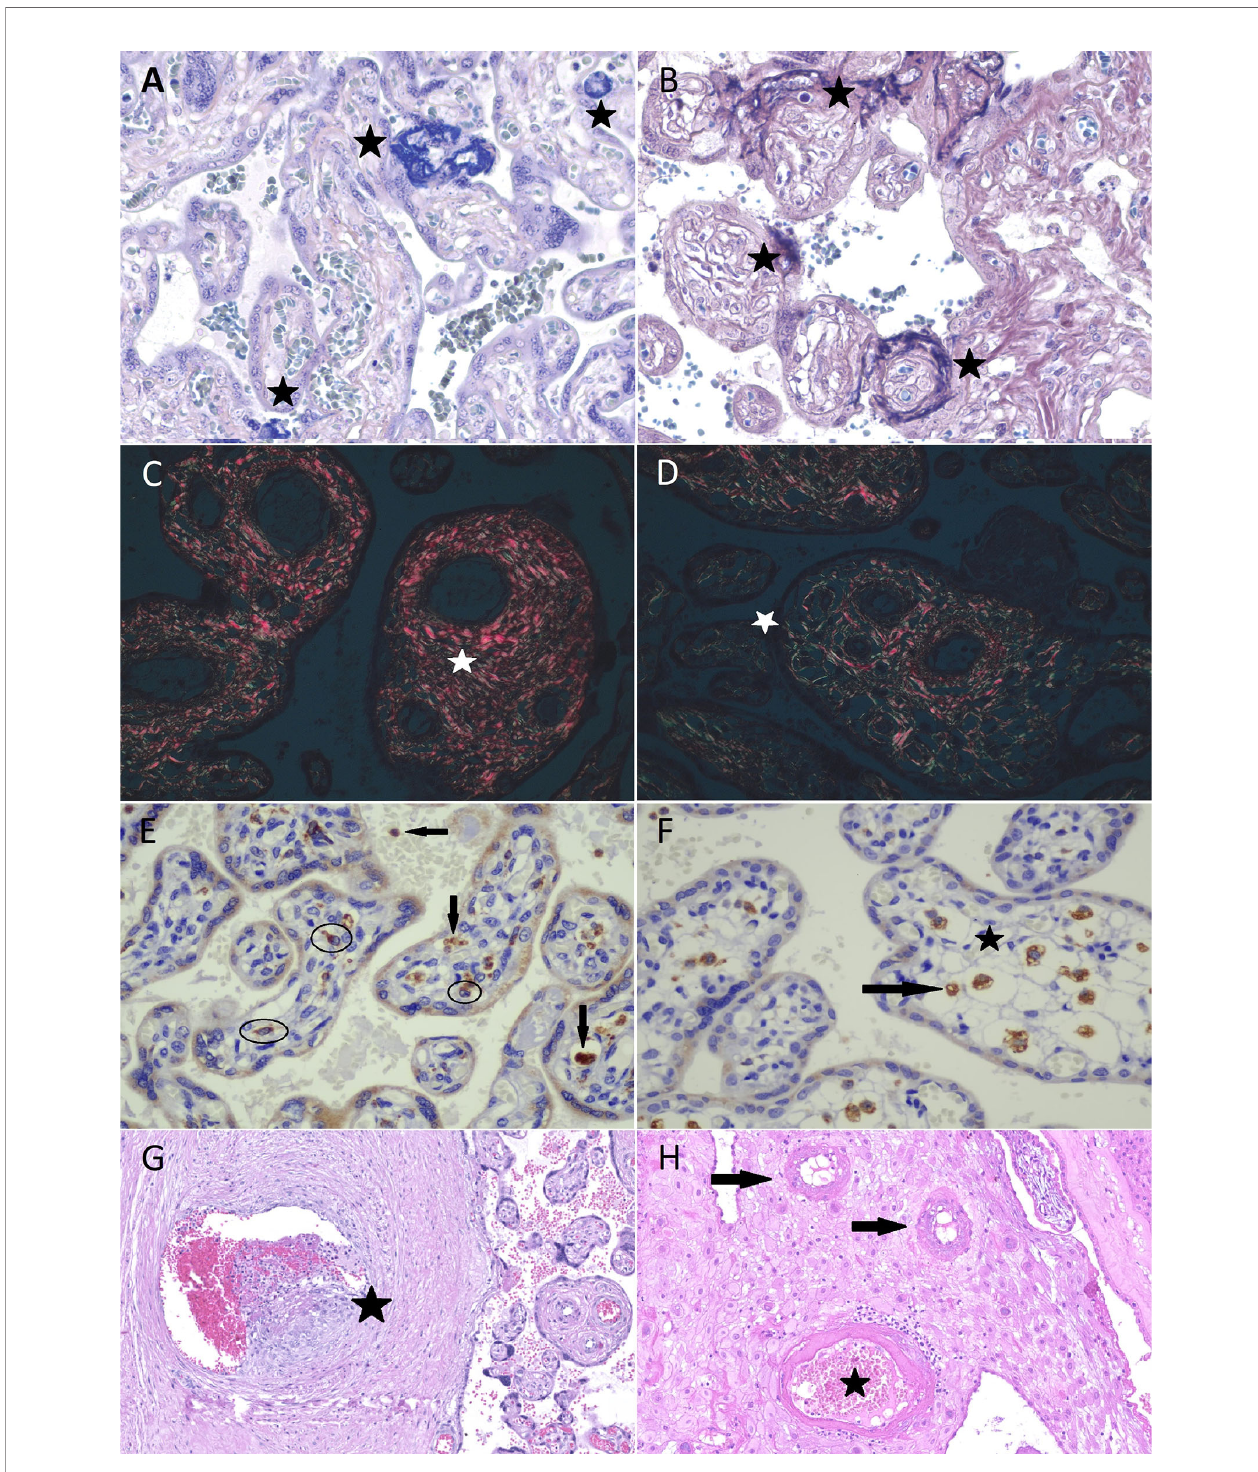
FIGURE 1 | Morphometric and morphological analysis of placental specimens from women infected with SARS-CoV-2 (COVID-19 group) and the Control Group. Fibrin deposition evaluation in COVID-19 group (A) and Control group (B) in phosphotungstic hematoxylin (star — deep blue amorphous material); both perivillous and intravillous deposition were included. Sirius Red: bright red collagen I (C) and green collagen III fi bers (D) under polarized light. Photomicrography of immunostaining with CD68 (KP1 Clone, Biocare) in COVID-19 group (E) and in Control group (F) ; eligible Hofbauer cells to counting (circled cells and those near the star). Macrophages outside villi and unspeci fi c marking were excluded (arrows). Fetal vascular thrombosis (G) and decidual vasculopathy (H) in COVID-19